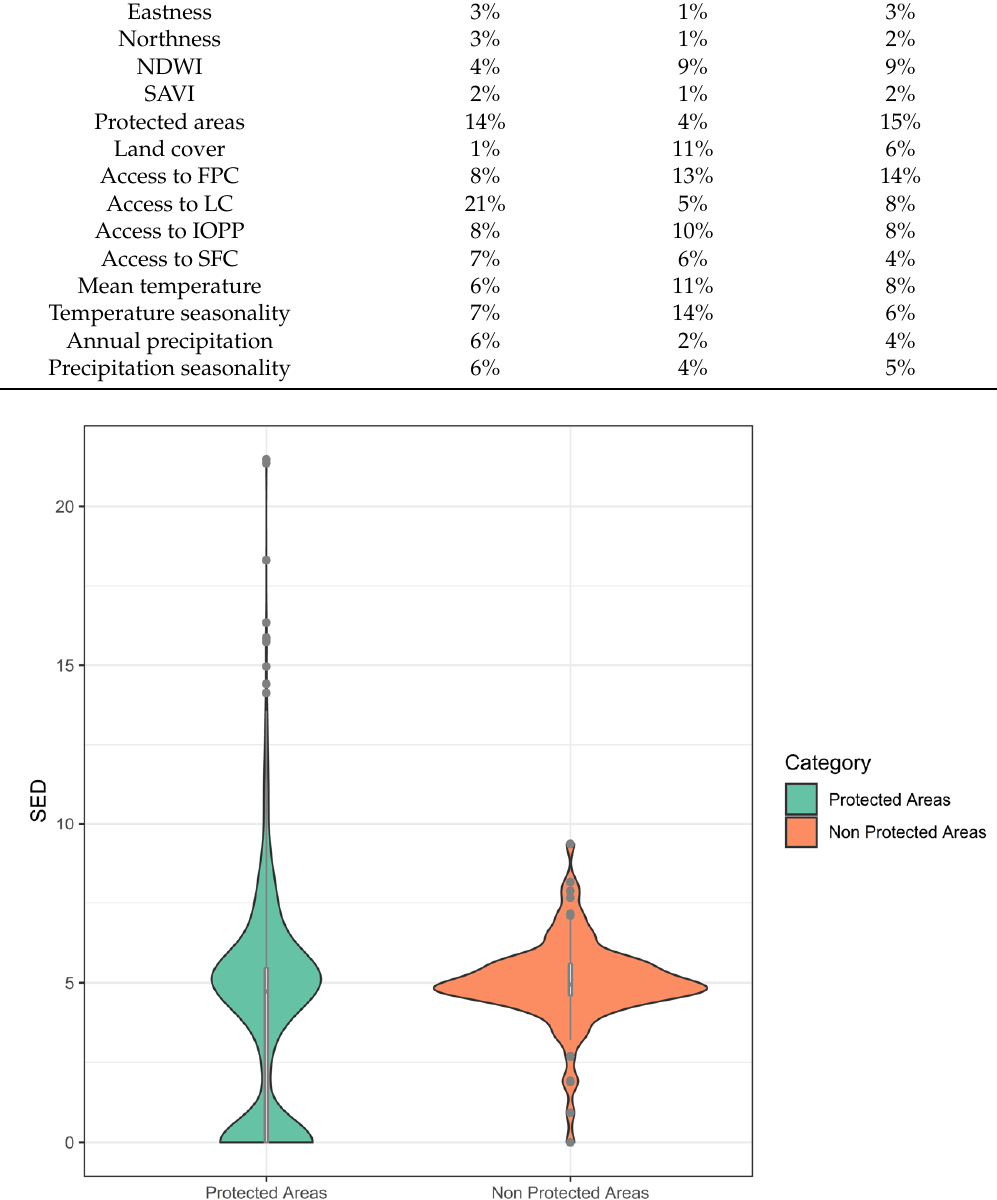
Figure 2. Climatic exposure based on standardized Euclidean distance of climate parameters within protected and non-protected areas.